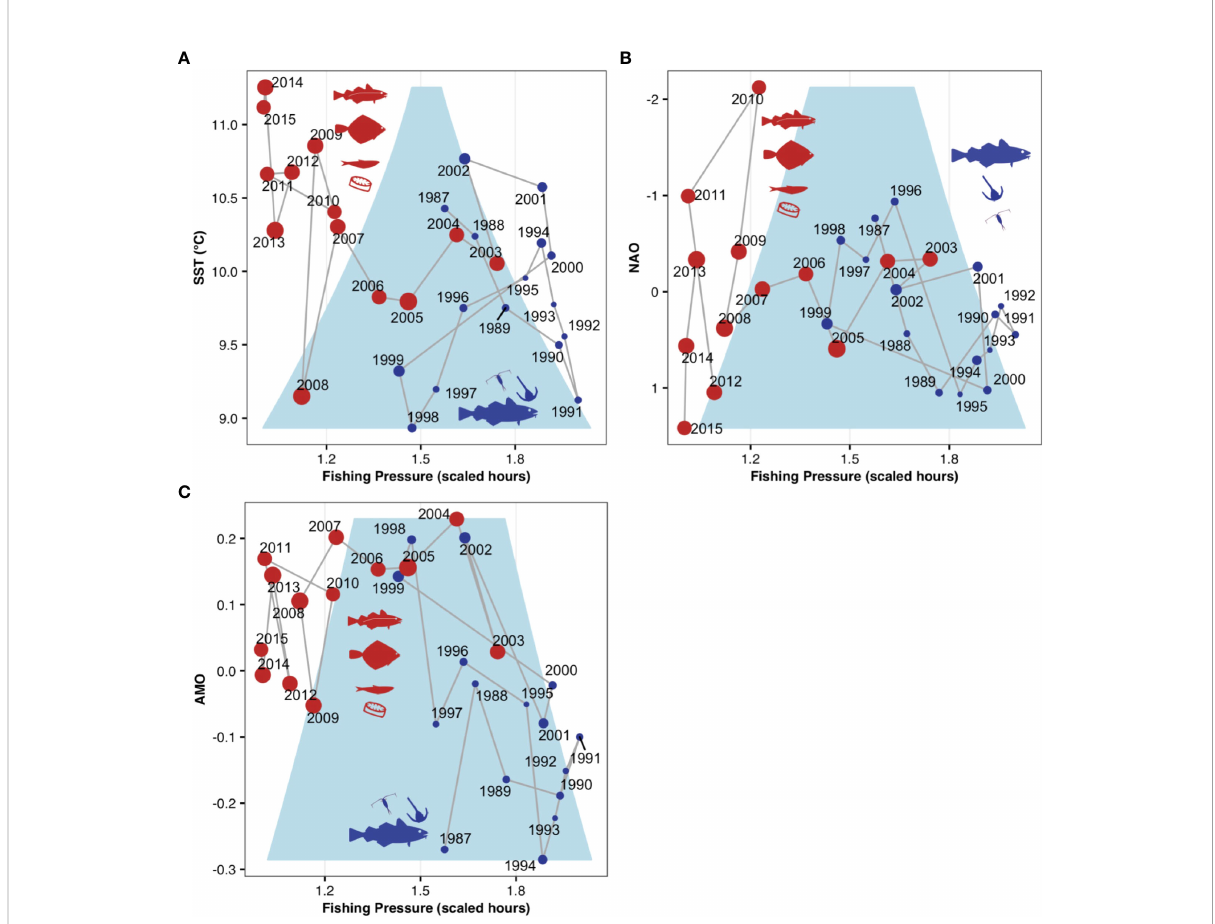
FIGURE 3 Potential irreversibility of a regime shift in the North Sea ecosystem. Results of stochastic cusp modelling showing predicted PC1 scores in relation to fi shing pressure and (A) , sea surface temperature (SST) (B) , the index of the North Atlantic Oscillation (NAO), and (C) , the index of the Atlantic Multidecadal Oscillation (AMO). Points are scaled according to PC1 scores; colors and regimes-speci fi c species/taxonomic groups according to Figure 2; the light blue area represents the cusp area (below the fold) in which the system can exist in three states, two stable and one unstable and can therefore fl ip from a state to the other. Note that NAO values are on a reverse